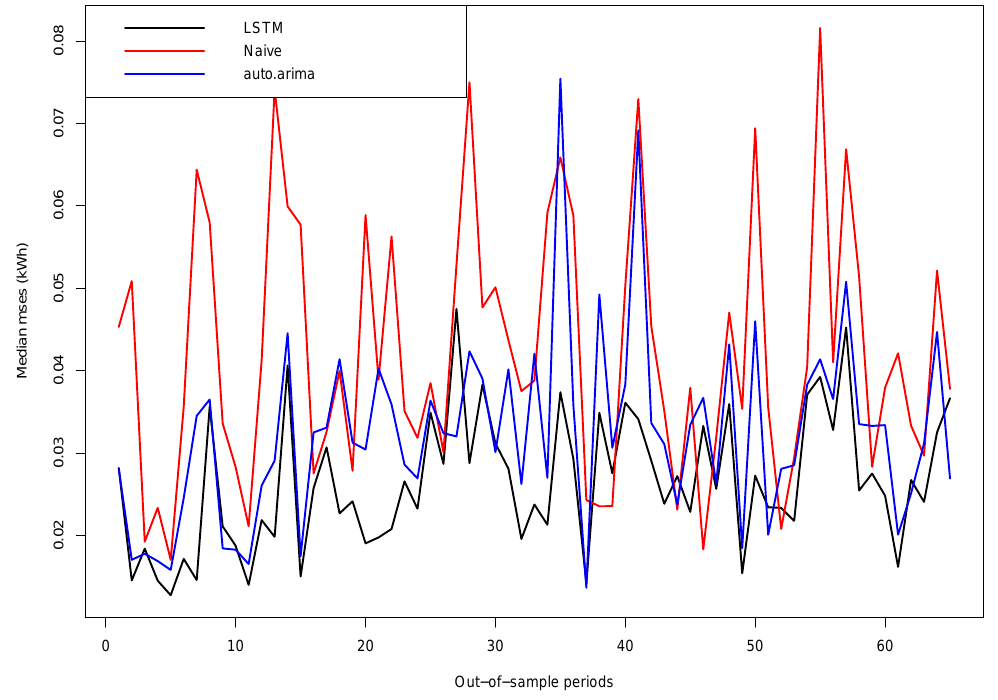
Figure 15. Out-of-sample performance for testing days (ACORN-U group).